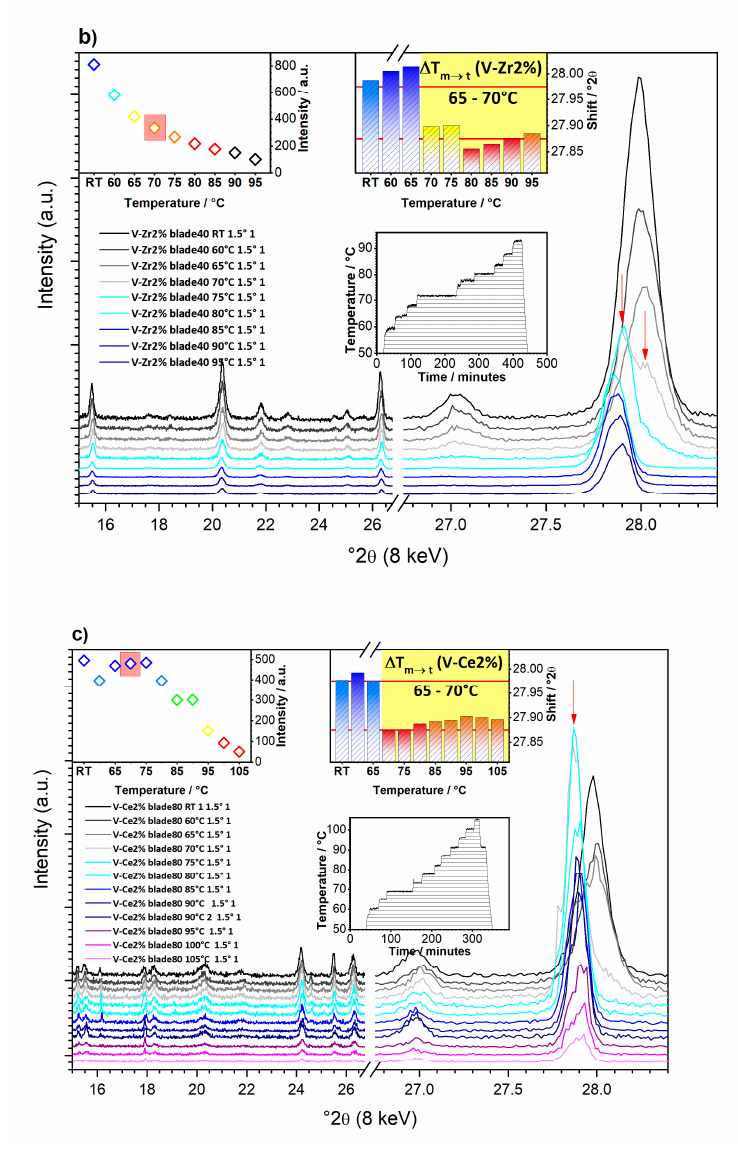
Figure 3. In-operando GIXRD results at 1.5° θ : ( a ) vanadium oxide (V), ( b ) zirconium-doped vanadium oxide (V-Zr2%), and ( c ) cerium-doped vanadium oxide (V-Ce2%). Insets: relative intensity of 011 VO 2 (M) + 110 VO 2 (T) peaks (upper left); relative shift; and thermal regime (middle). The peak at ~28° 2 θ ((011) reflection in VO 2 (M)) better marks this transition (Figure 3a–c Inset),